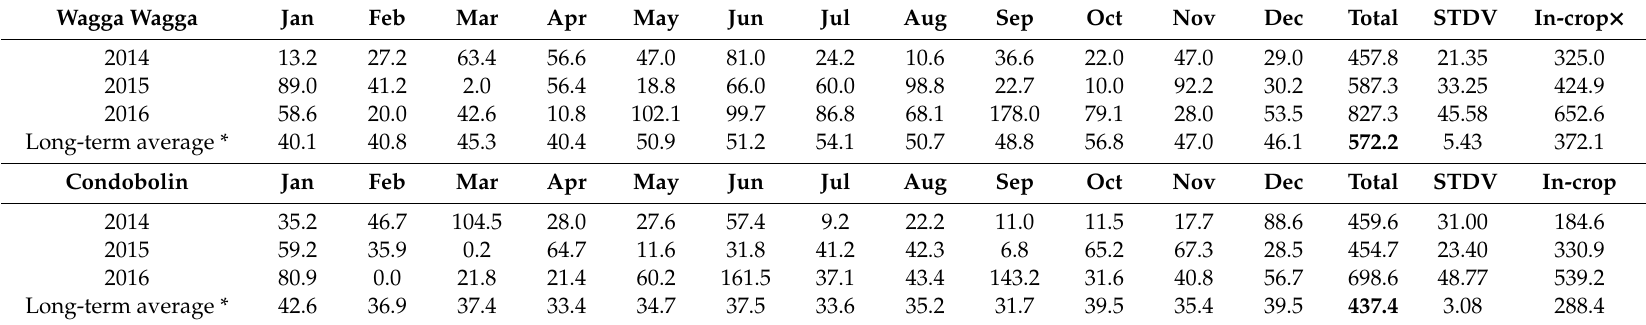
Table 2. Monthly rainfall (mm) and the total in-crop rainfall for the Wagga Wagga and Condobolin canola field trial sites in 2014, 2015, and 2016 from Australian government bureau of